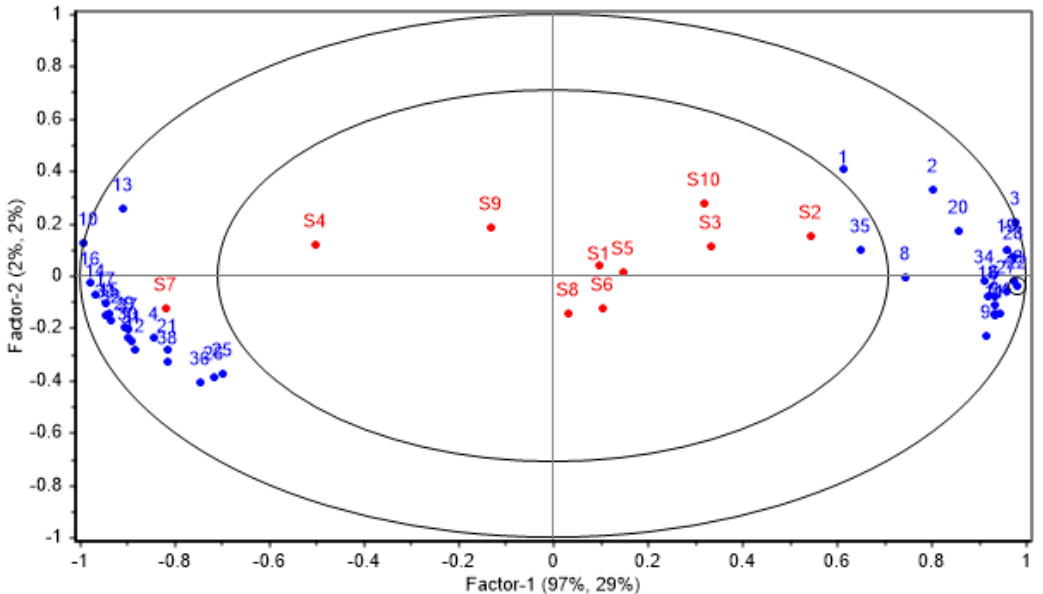
Figure 7. Bioplot for the correlation between volatile components and the E-nose sensor responses (1~38: the 38 selected compounds, the numbers are same as the selected compounds in Table 3)